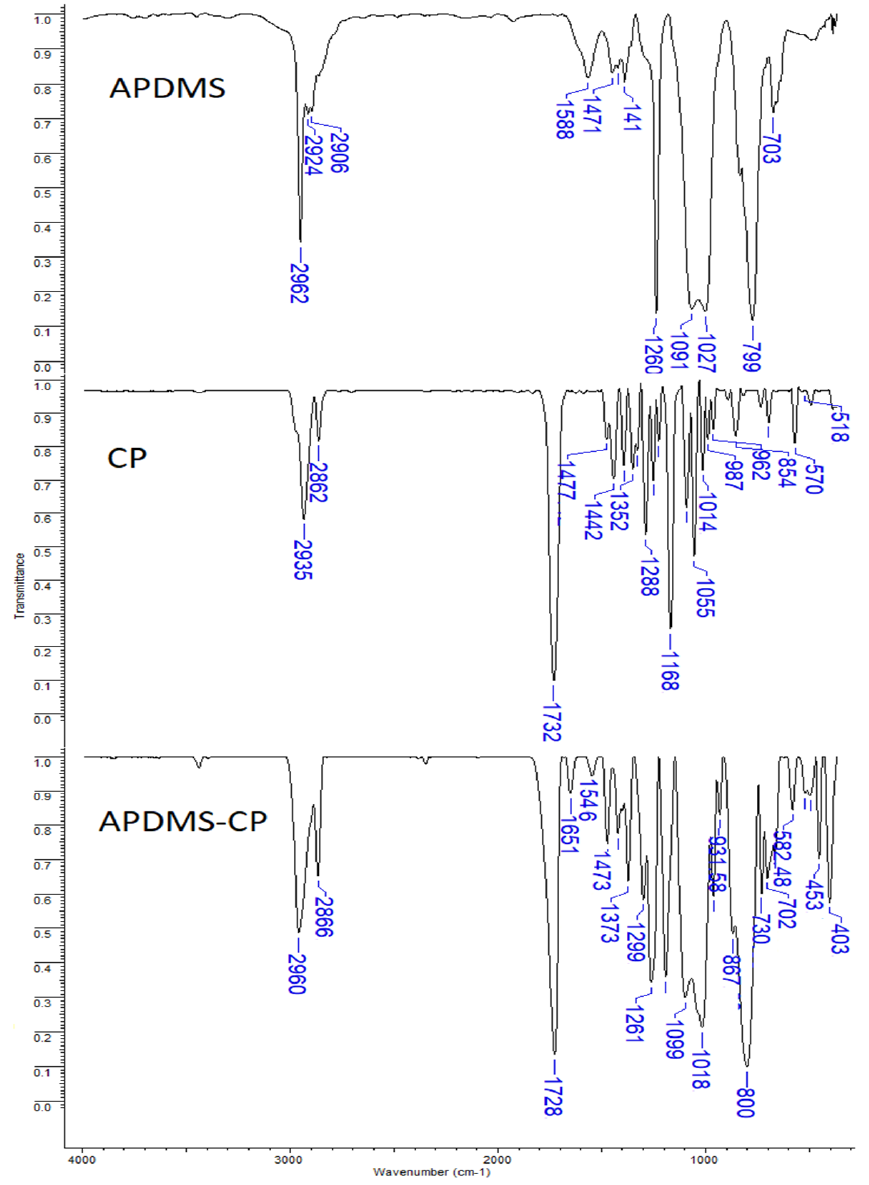
Figure 1. Infrared spectrum of APDMS, CL, and APDMS-CL. The amide I (from the C=O stretching vibrations) and amide II (from the C–N stretching and CNH) bands correspond to 1651 and 1546 cm − 1 , respectively [32,33]. The synthesis of the well-defined copolymer was confirmed by the NMR spectrum (Figure